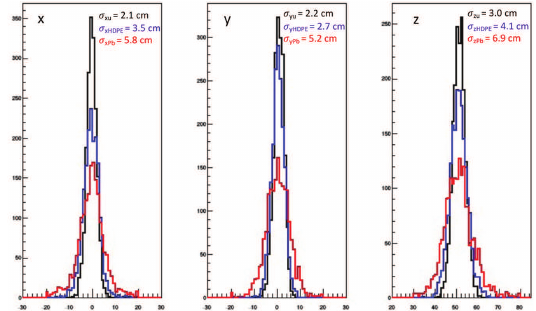
Fig. 7. Projections of measured source position distributions on the x -, y - and z -axis for different shielding conditions. A total number of 1800 10-s measurements were performed for each case. Black: bare source, blue: source inside a 4-cm radial thickness HDPE cylinder, red: source inside a 1.6 cm radial thickness lead cylinder. The Cf-252 source was placed at ( x, y, z ) = (0 , 0 , 52) cm in the coordinate system indicated in Figure 4. Taken from reference [29].